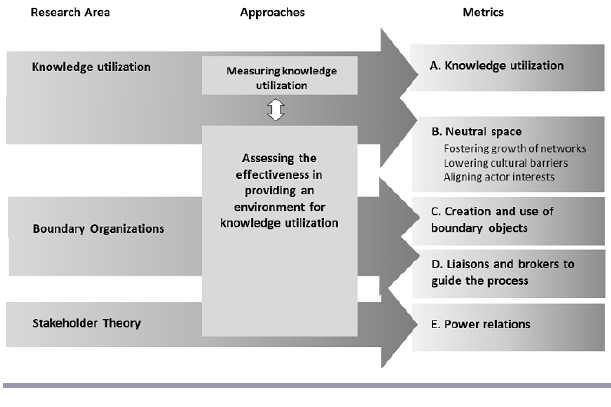
Fig. 2 . An integrated conceptual framework for studying knowledge utilization in bridging organizations. The figure shows the approaches to studying learning in bridging organizations proposed in our research (middle column) and the suggested metrics associated with the operationalization of each (right column). The arrows indicate the research area from which the methods and metrics are drawn and how these feed into each of the two suggested approaches. The vertical arrow indicates that the two approaches are mutually complementary and should be pursued in